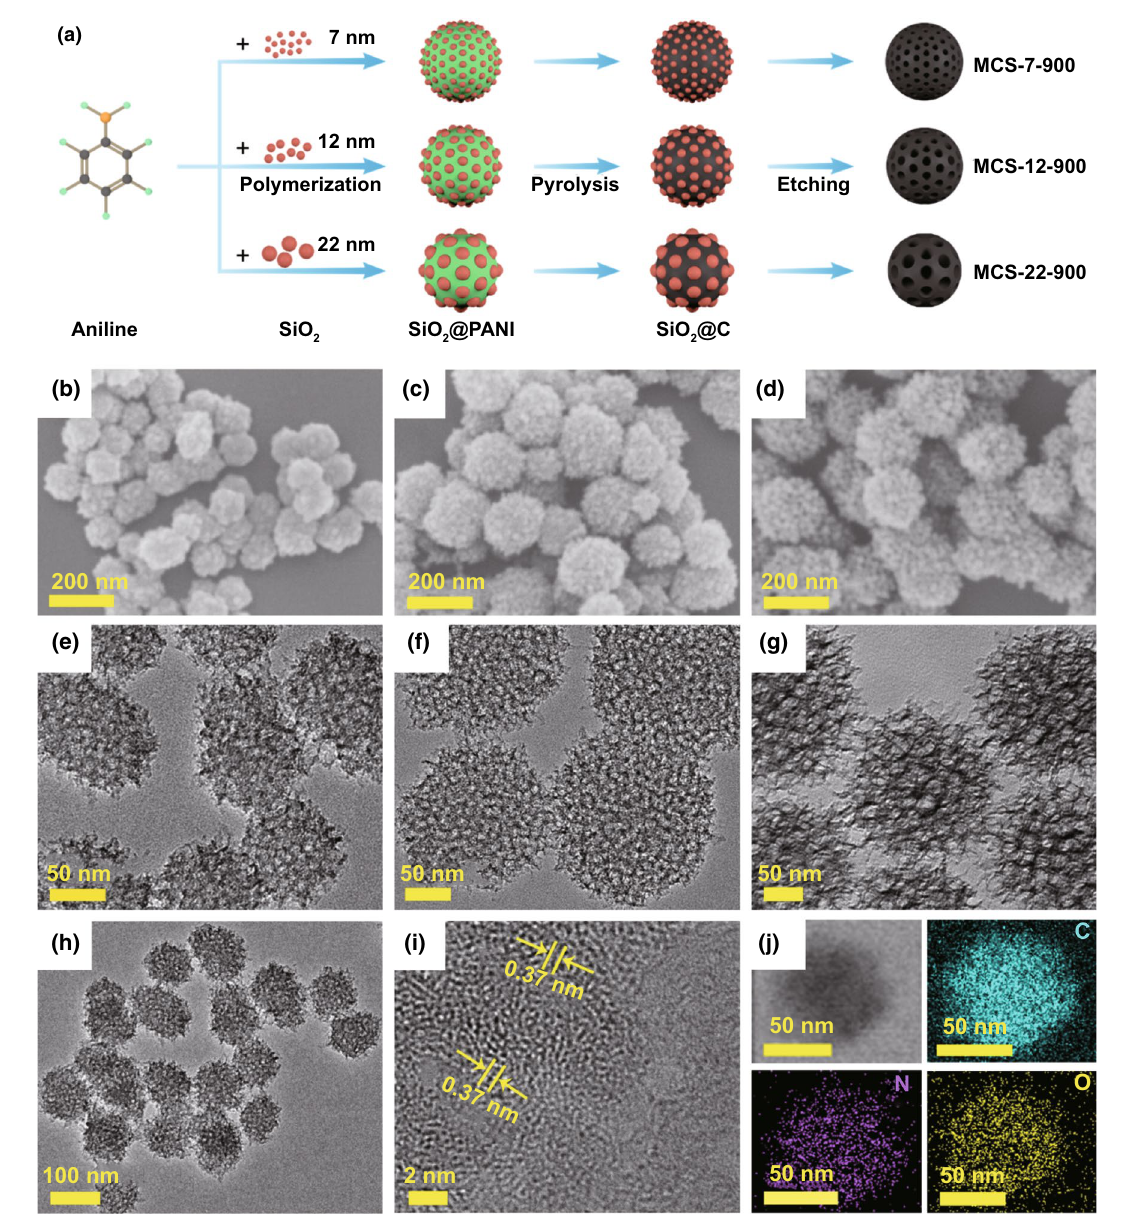
Fig. 1 a Diagrammatic sketch of the preparation procedure of MCS-7-900, MCS-12-900 and MCS-22-900. SEM images of b MCS-7-900, c MCS-12-900 and d MCS-22-900. High-magnification TEM images of e MCS-7-900, f MCS-12-900 and g MCS-22-900. h TEM image of MCS-7-900. i HRTEM image of MCS-7-900. j Electron image with corresponding EDS mapping of